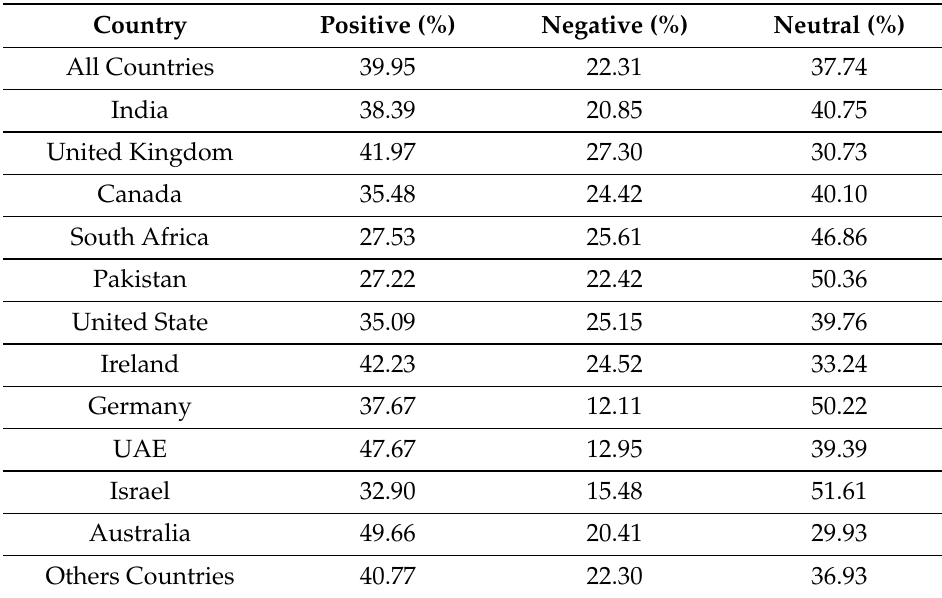
Figure 10. VADER sentiment scores for each country. Table 12. VADER sentiment statistics for each country and